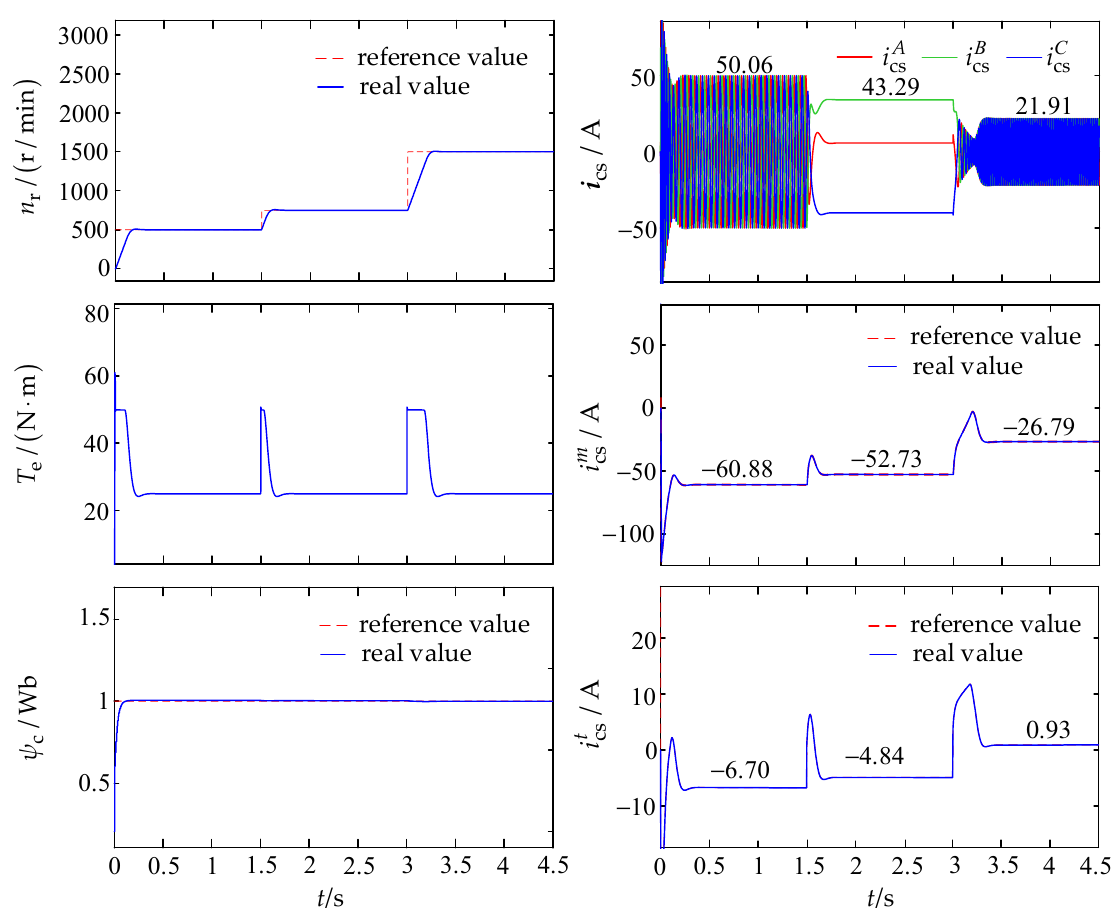
Figure 13. Simulation results of ψ ∗ c = constant control when speed changes.